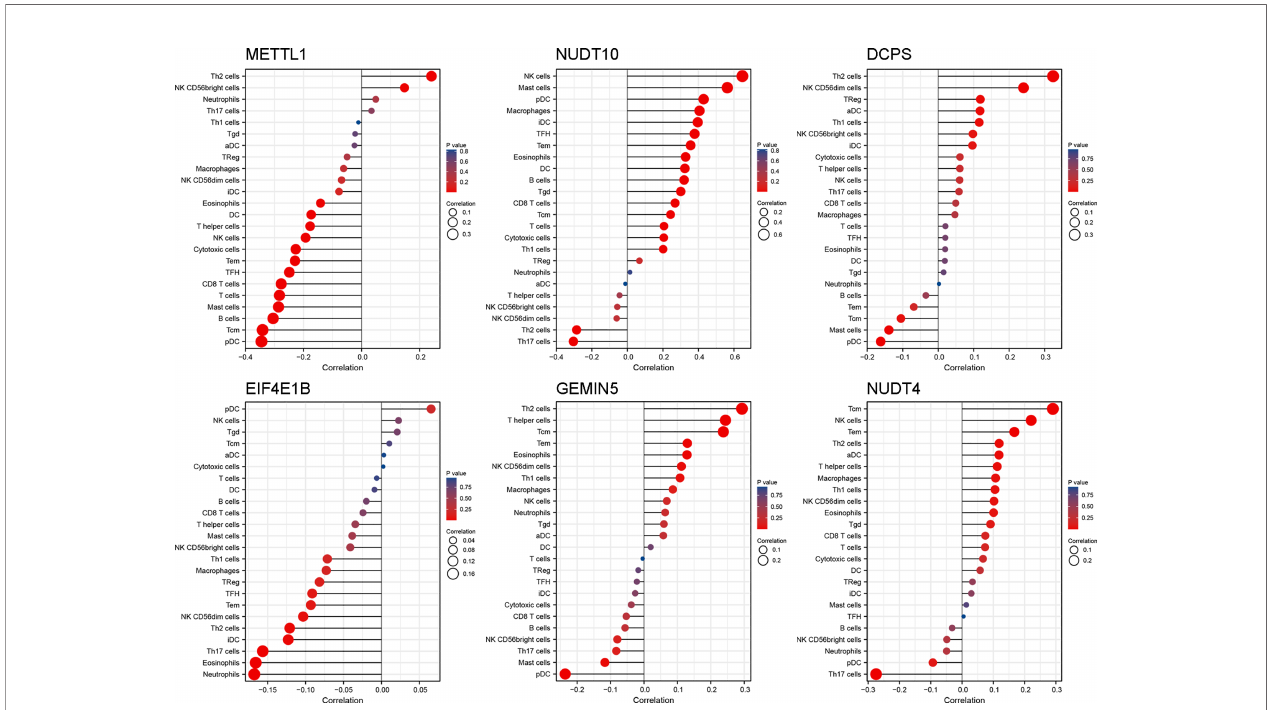
FIGURE 7 | The relationship between genes and immune cells. The color and size of the datapoint represent the direction and signi fi cance (P-value) of the